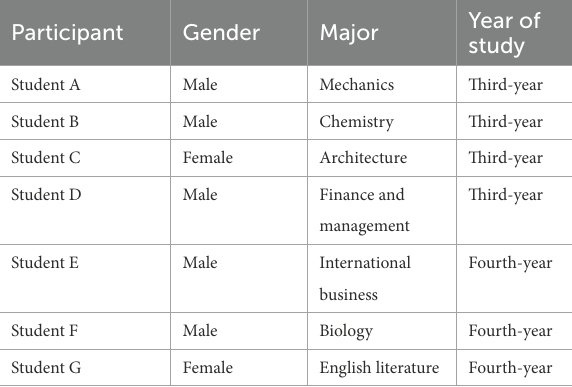
TABLE 1 Background information of participants.